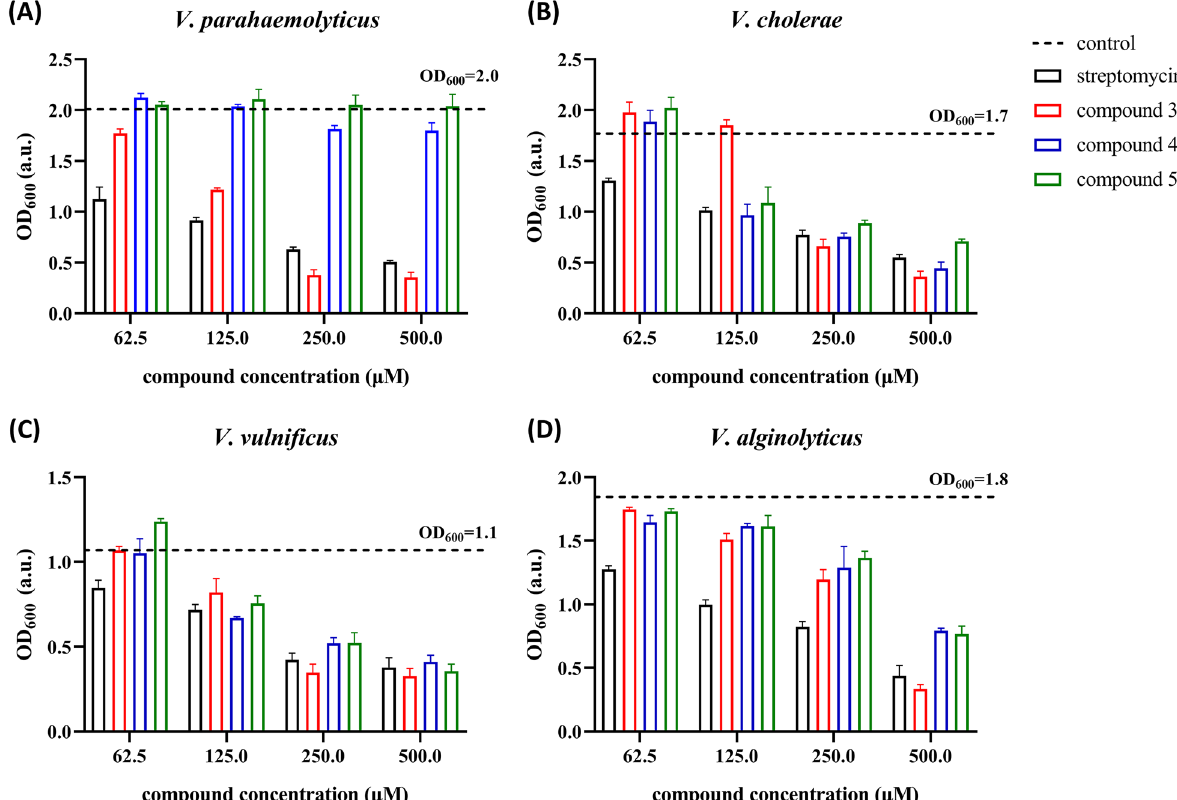
Fig. 2 Anti- Vibrio activity of compounds 3 , 4 and 5 . The anti- Vibrio activity on V . cholerae ( A ), V . parahaemolyticus ( B ), V . vulnificus ( C ) and V . alginolyticus ( D ) is shown as bar charts. The control lines represent the OD 600 of the control bacterial culture. The error bars represent the standard error of three parallel